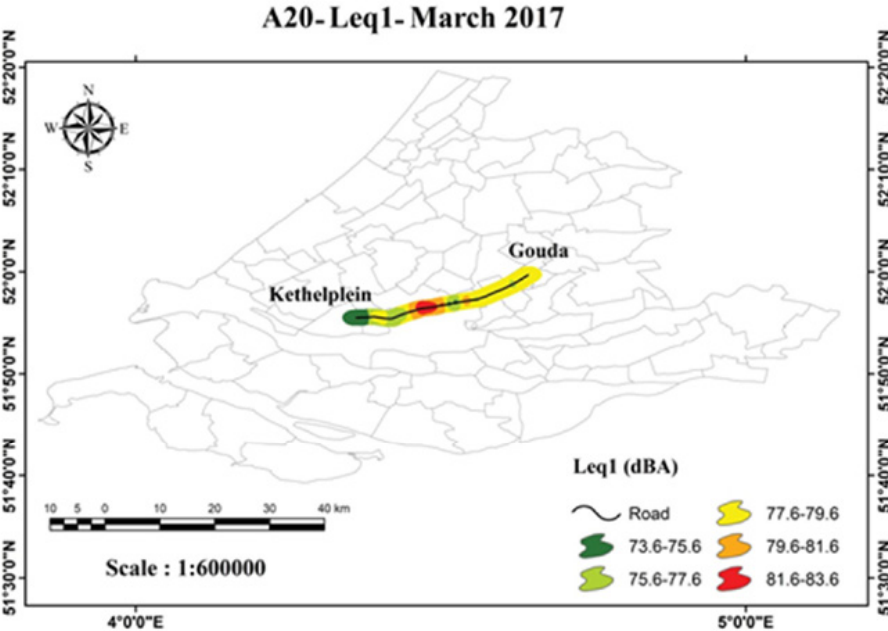
Fig. 3: Noise map (Leq1) in March 2017 for route A20 in the Netherlands (Ahmadi Dehrashid, 2018)